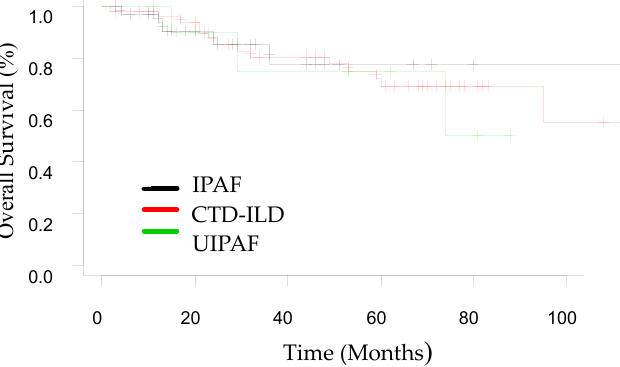
Figure 3. Comparison of survival curves of patients with IPAF, CTD-ILD and UIPAF. At 12 ± 3 months from the diagnosis (T1), the three groups signi fi cantly di ff ered in the frequency of patients with a FVC < 50% predicted or a DLCO < 35% predicted, in the